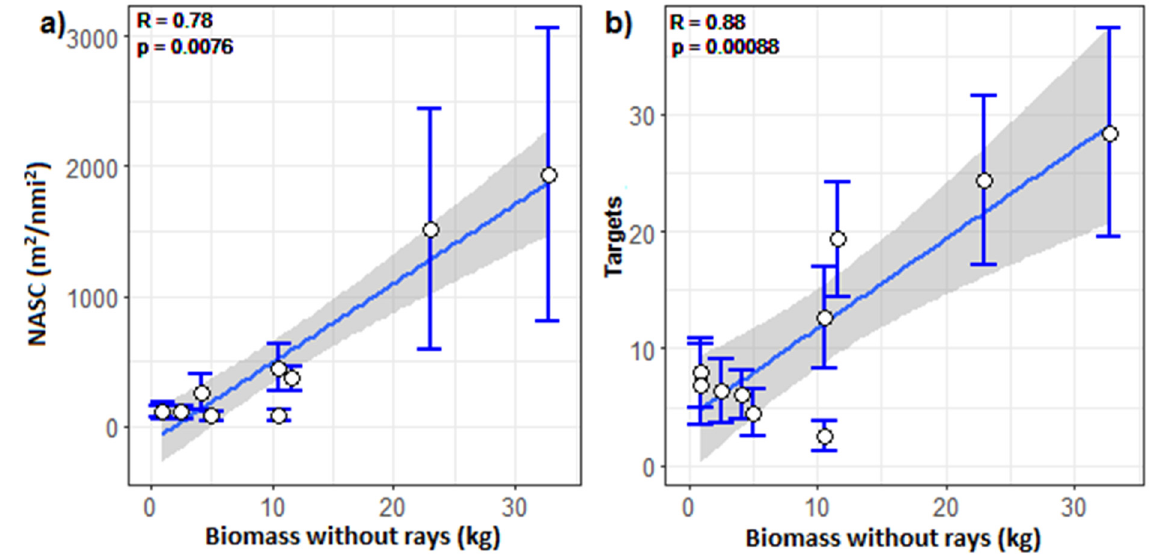
Figure 5. Correlations between ( a ) the relative biomass without rays from the stereo-BRUVs and the acoustic NASC BRUV-mean no schools using a 250 m radius of search around the stereo-BRUVs and including 10.5 m above the seafloor, ( b ) relative biomass without rays from the stereo-BRUVs and acoustic targets using a 400 radius of search around the stereo-BRUVs and including 10.5 m above the seafloor. The standard errors are shown as error bars. A linear regression with 95% confidence intervals is shown as a blue line with a grey band.